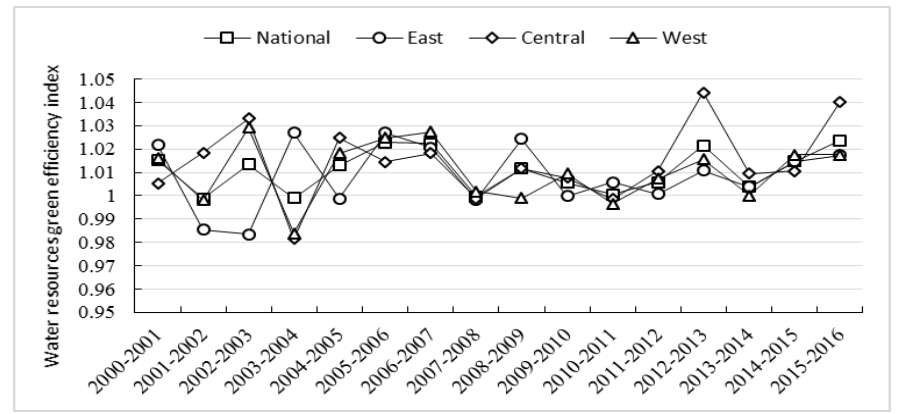
Figure 1. National and regional changes in water resources green efficiency during the study period 2000–2016.